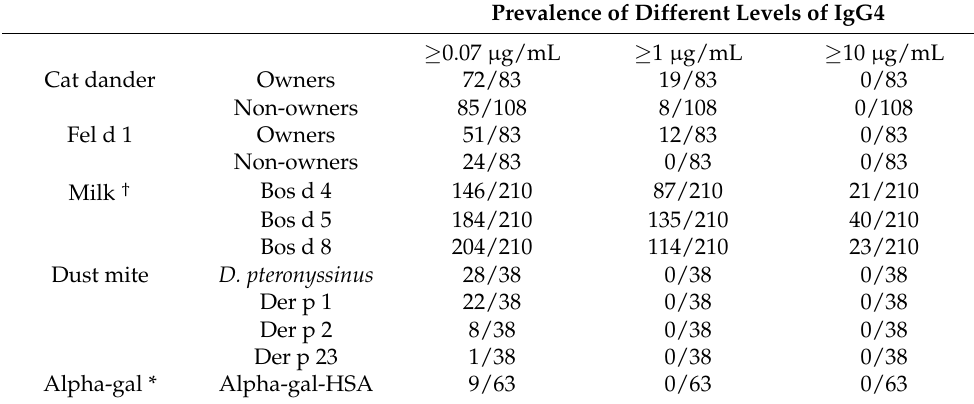
Table 1. IgG4 antibody titers to cat and milk antigens in children with a high exposure compared with IgG4 antibodies to dust mites and alpha-gal (Unpublished data and data adapted from Schuyler et al. ϯ [15] and Wilson et al.* [37]).